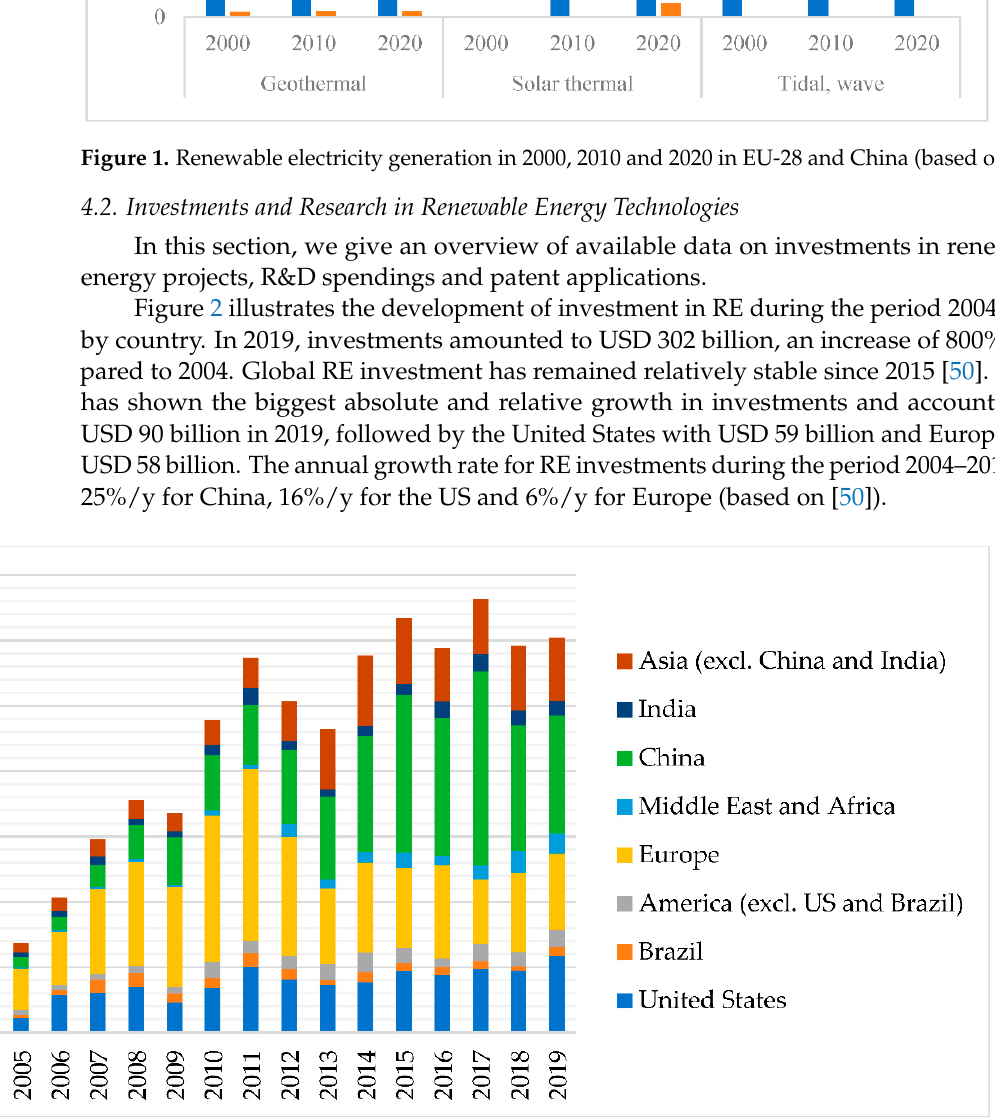
Figure 2. Evolvement of total renewable energy investment from 2004 to 2019 (based on [50], p. 62).